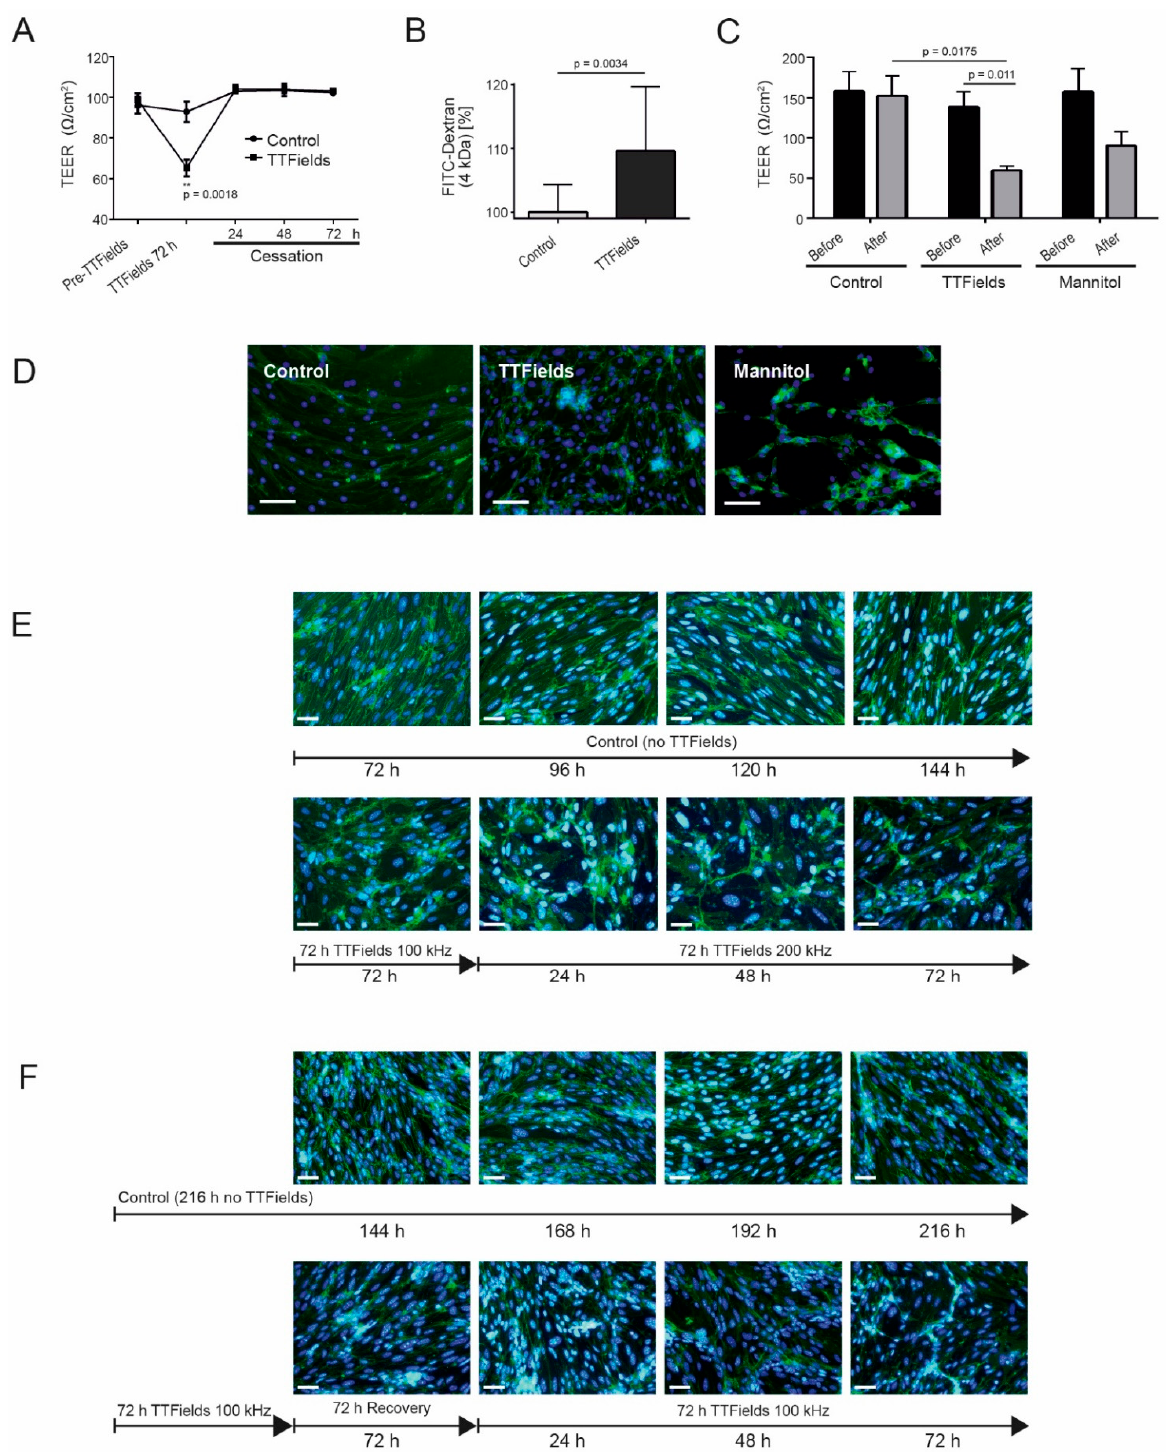
Figure 3. While TTFields did not affect cerebEND cell viability, they altered BBB integrity and permeability repeatedly. ( A ) TEER was measured before (pre-TTFields), directly after 72 h treatment with TTFields at 100 kHz, and during a 72 h recovery period (cessation). Asterisks indicate significant differences compared to the control of the same time point. ( B ) TTFields effects at 100 kHz on cell permeability were evaluated by a FITC-dextran permeability assay. ( C ) cerebEND cells were treated with either TTFields at 100 kHz for 72 h or 1.4 M mannitol for 24 h. The values shown in ( A – C ) are the mean of three independent experiments. Statistical significance was evaluated using an